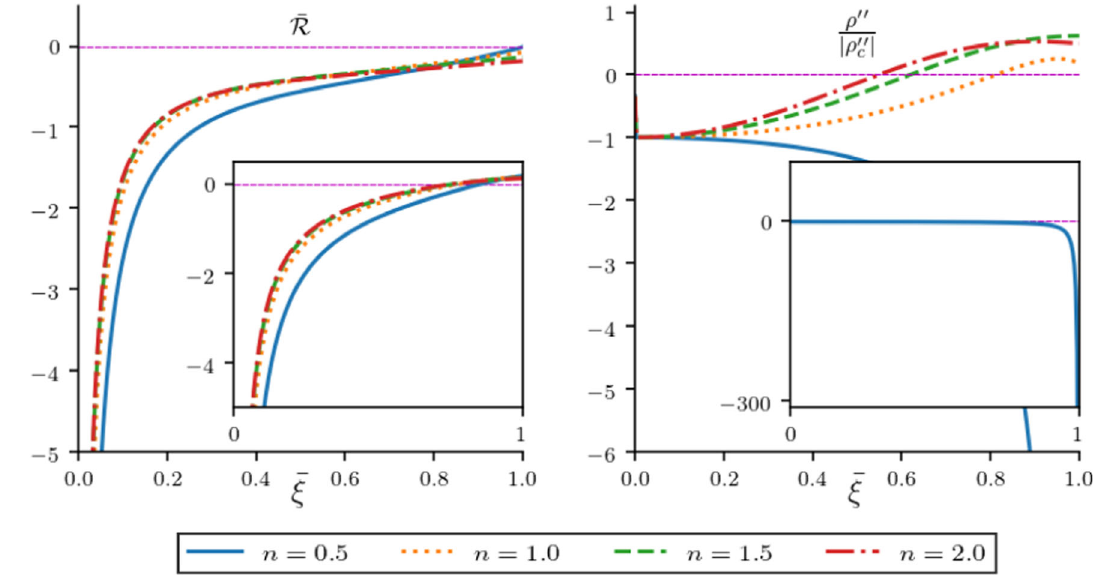
Fig. 7 Perturbed hydrostatic equilibrium equation (left plate) and con- vective adiabatic stability criterion (right plate) as a function of ¯ ξ for the Lane–Emden master equation, for models with parameters α = − 0 . 01, (cid:18) = 0 . 17, σ = 0 . 175, C = 0 . 05 and several values of n . There are no changes in the sign of ¯ R in the left plate. Therefore there is no cracking oroverturningwithinthematerialconfiguration:allmodelsshownfulfil